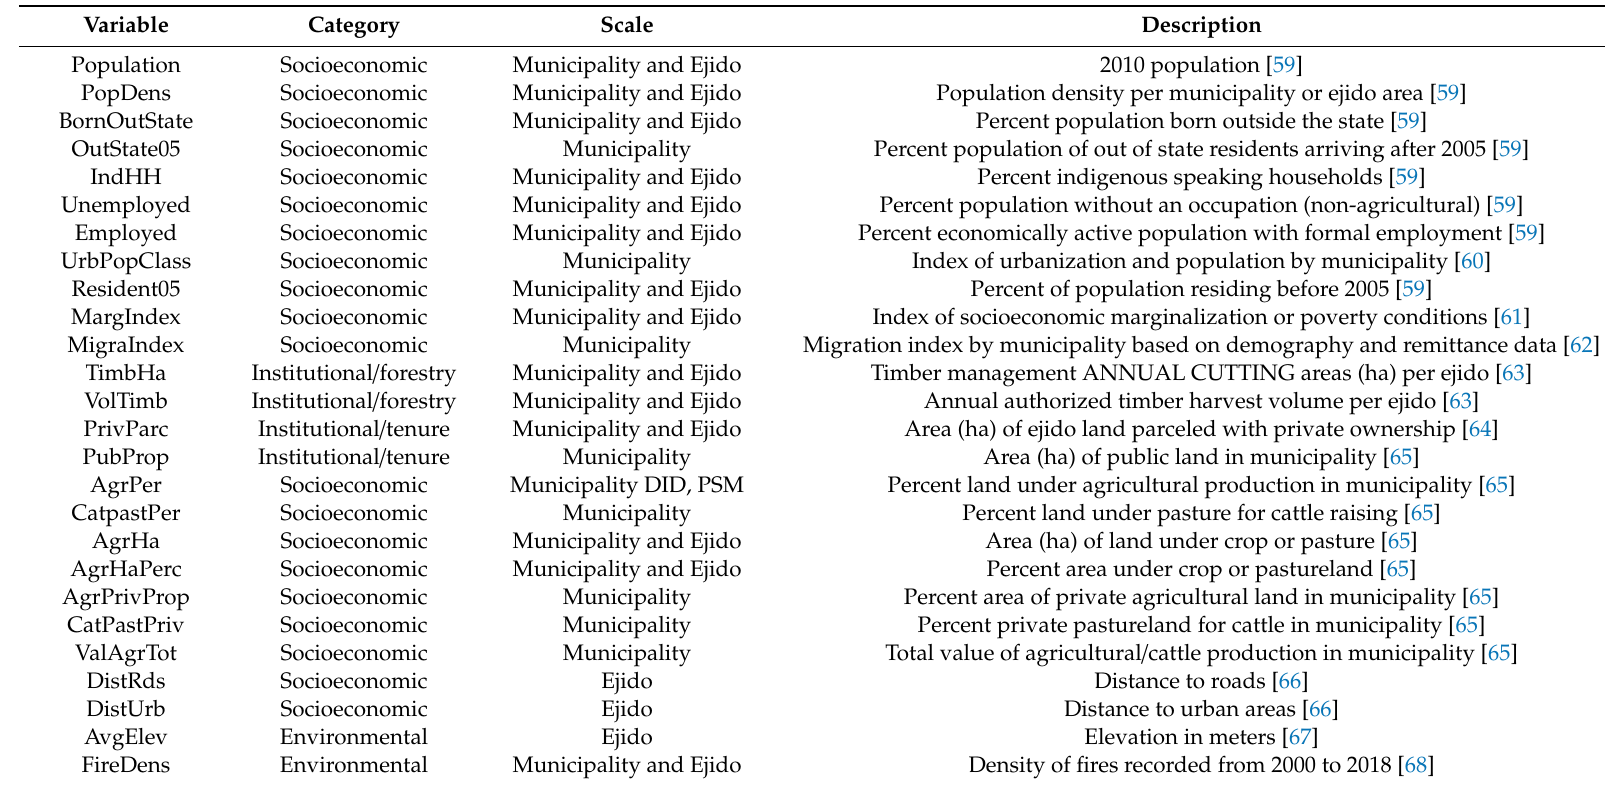
Table 1. Covariates used in quasi-experimental analyses Di ff erence-in-Di ff erences (DID), Propensity Score Matching (PSM), and Synthetic Control Method (SCM)) of REDD + e ff ectiveness in reducing forest cover loss at meso (municipal) and micro (ejido community) scales on the Yucatan